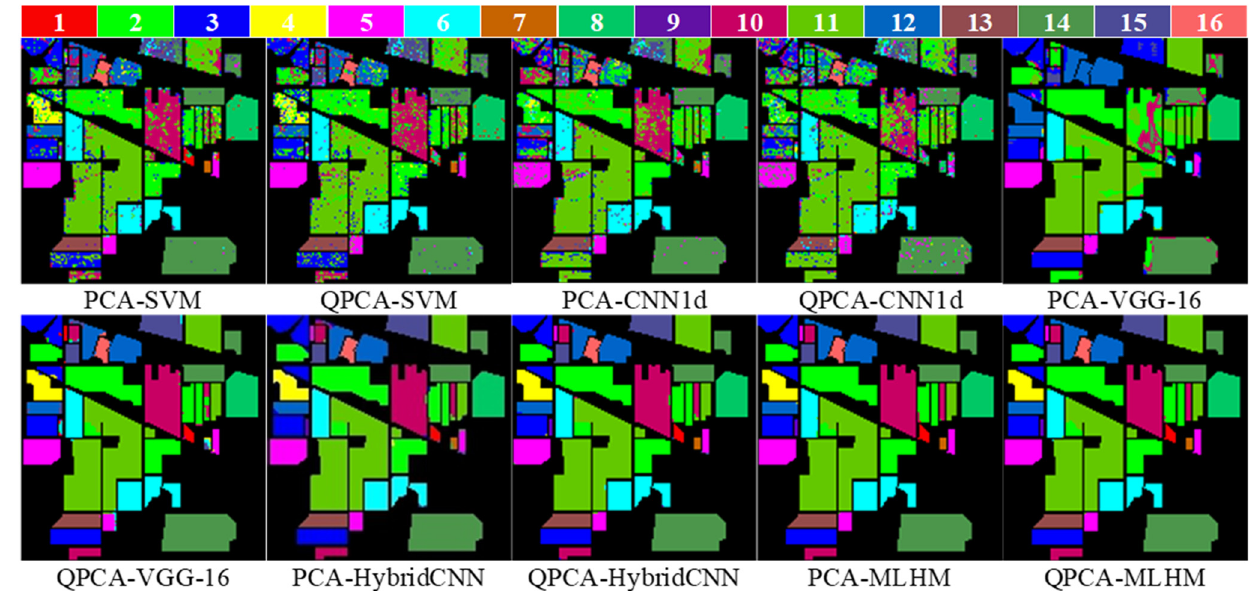
Figure 8. The output of the various models with PCA and QPCA preprocessing for the IPs dataset.